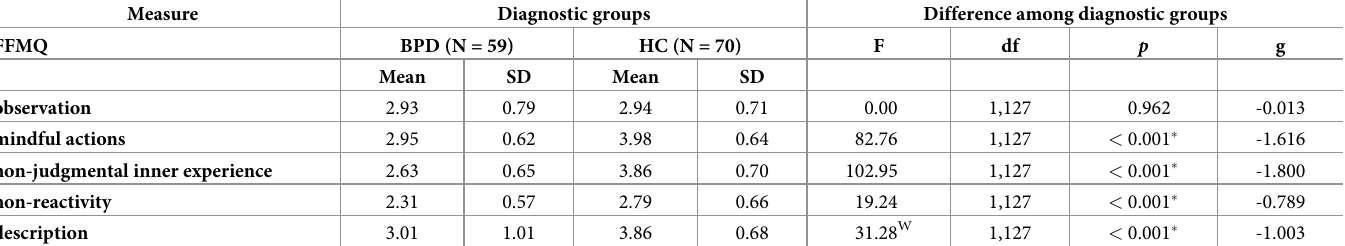
Table 6. Group comparisons of the BPD and HC groups on the subscale scores of the five factor mindfulness questionnaire, and effect sizes measured by Hedge’s g formula. Measure